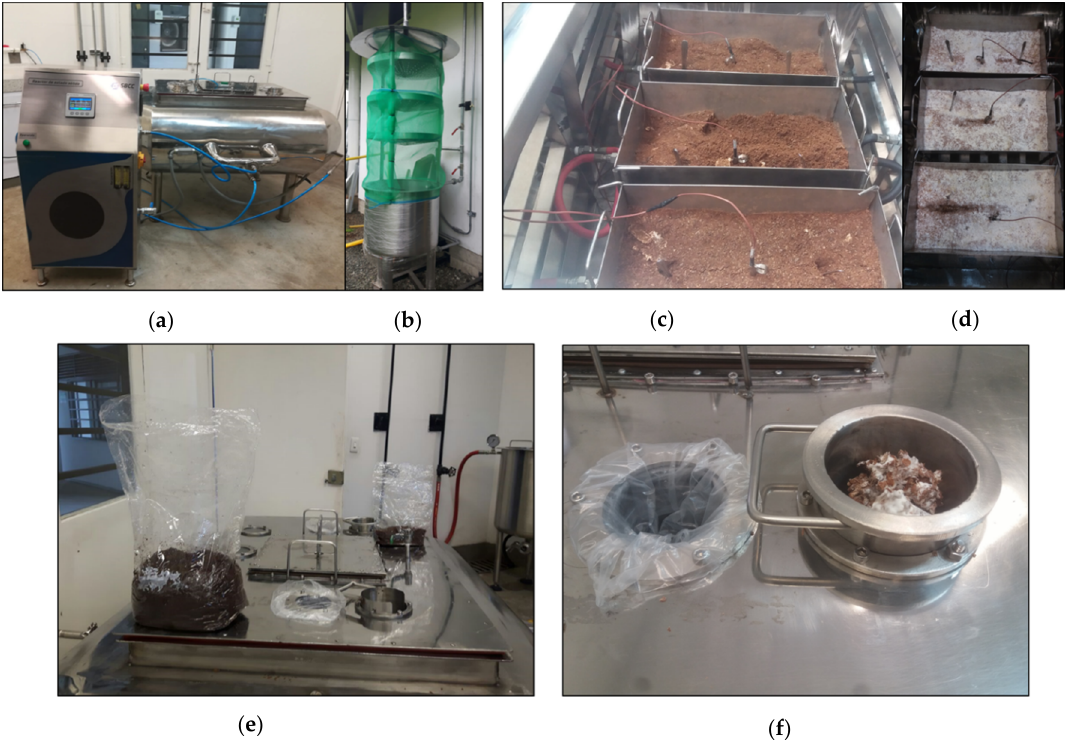
Figure 1. Details of the fixed-bed pilot-scale bioreactor. ( a ) Body of the bioreactor with panel for temperature control and air supply device. ( b ) Perforated-plate cooling tower for water recycling. ( c ) Bioreactor boxes loaded with 10 kg inoculated substrate each. ( d ). Boxes with colonized substrate. ( e ) Loaded bioreactor under operation. ( f ) Sampler for follow-up of the fermentation process.